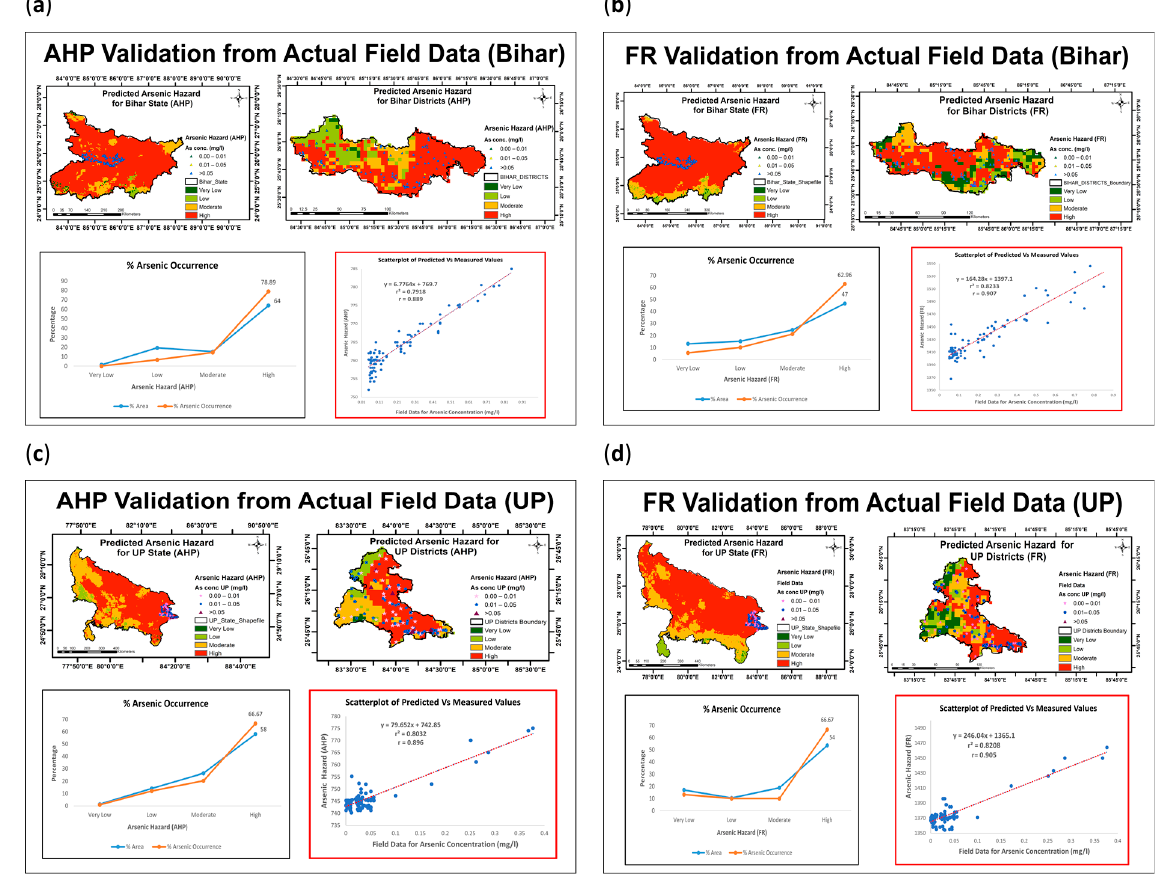
Figure 7. Validation through actual field data for: ( a ) AHP (Bihar); ( b ) FR (Bihar); ( c ) AHP (UP); ( d ) FR (UP). Each part represents four sections: (i) predicted arsenic hazard with the data points in the selected state boundaries; (ii) predicted arsenic hazard and the data points with the district boundaries for the selected districts; (iii) the percentage of arsenic occurrence; and (iv) a scatterplot of the predicted hazard index values and actual arsenic